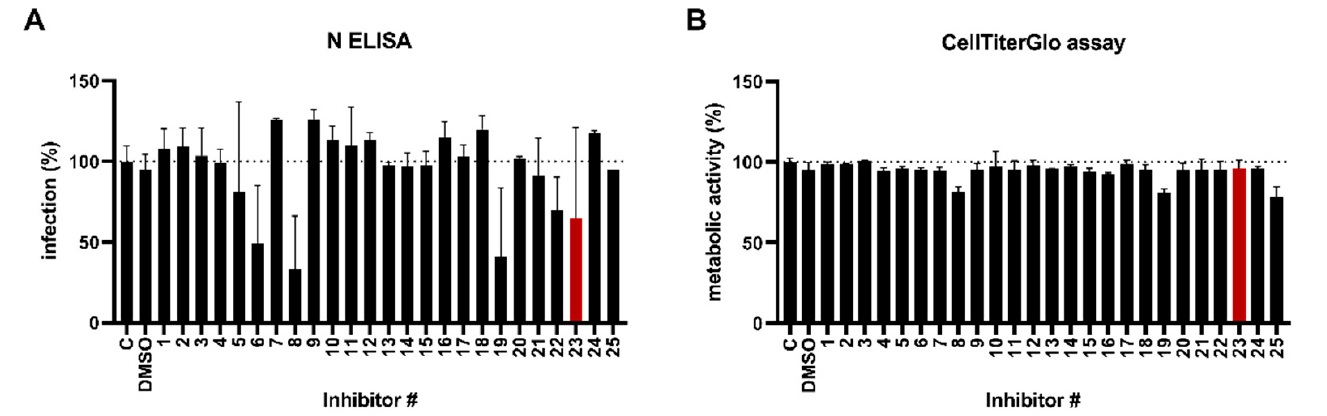
Figure 1. Screening of kinase inhibitors against SARS-CoV-2. ( A ) Compounds were prediluted in medium and added onto Caco-2 cells (final conc. 1 µ M). Afterwards, cells were infected with SARS- CoV-2 Alpha (MOI of 0.0005) and 2 days later, infection was quantified by an in-cell ELISA. Values were corrected for the background signal derived from uninfected cells and untreated controls were set to 100% infection. ( B ) In parallel, a viability assay was performed under conditions corresponding to the respective infection assay. Metabolic activity of the cells was assessed 2 days later using the CellTiter-Glo ® Luminescent Cell Viability Assay. Untreated controls were set to 100% viability. Shown are mean values ± SD from one experiment performed in triplicates. Red bar indicates compound of interest SB431542 (Inhibitor # 23), C: control.